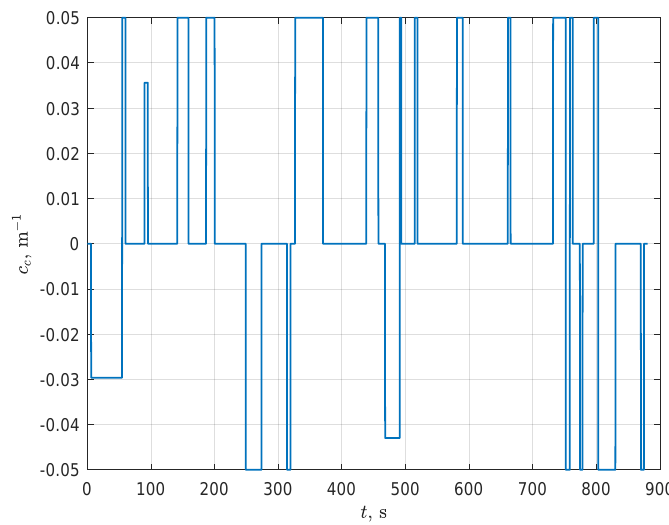
Figure 13. Evolution of the path curvature in Scenario